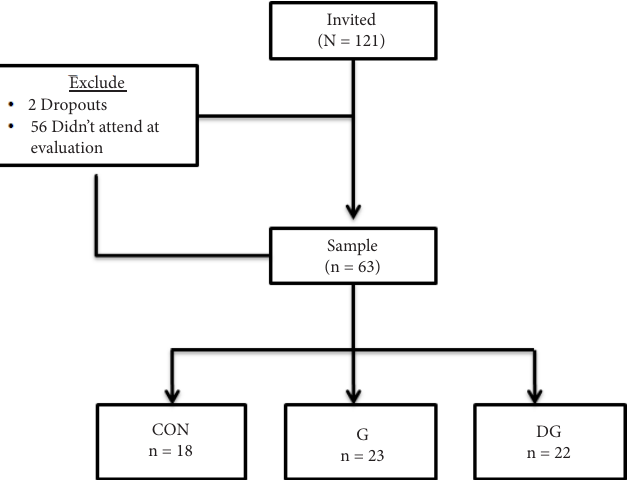
Figure 1. Flowchart of all invited and tested students. CON - con- trol group that did not use the diary and did not receive guidance on healthy lifestyles (GHL); G - group that did not use the diary, but re- ceived GHL; DG - group that both used the diary and received